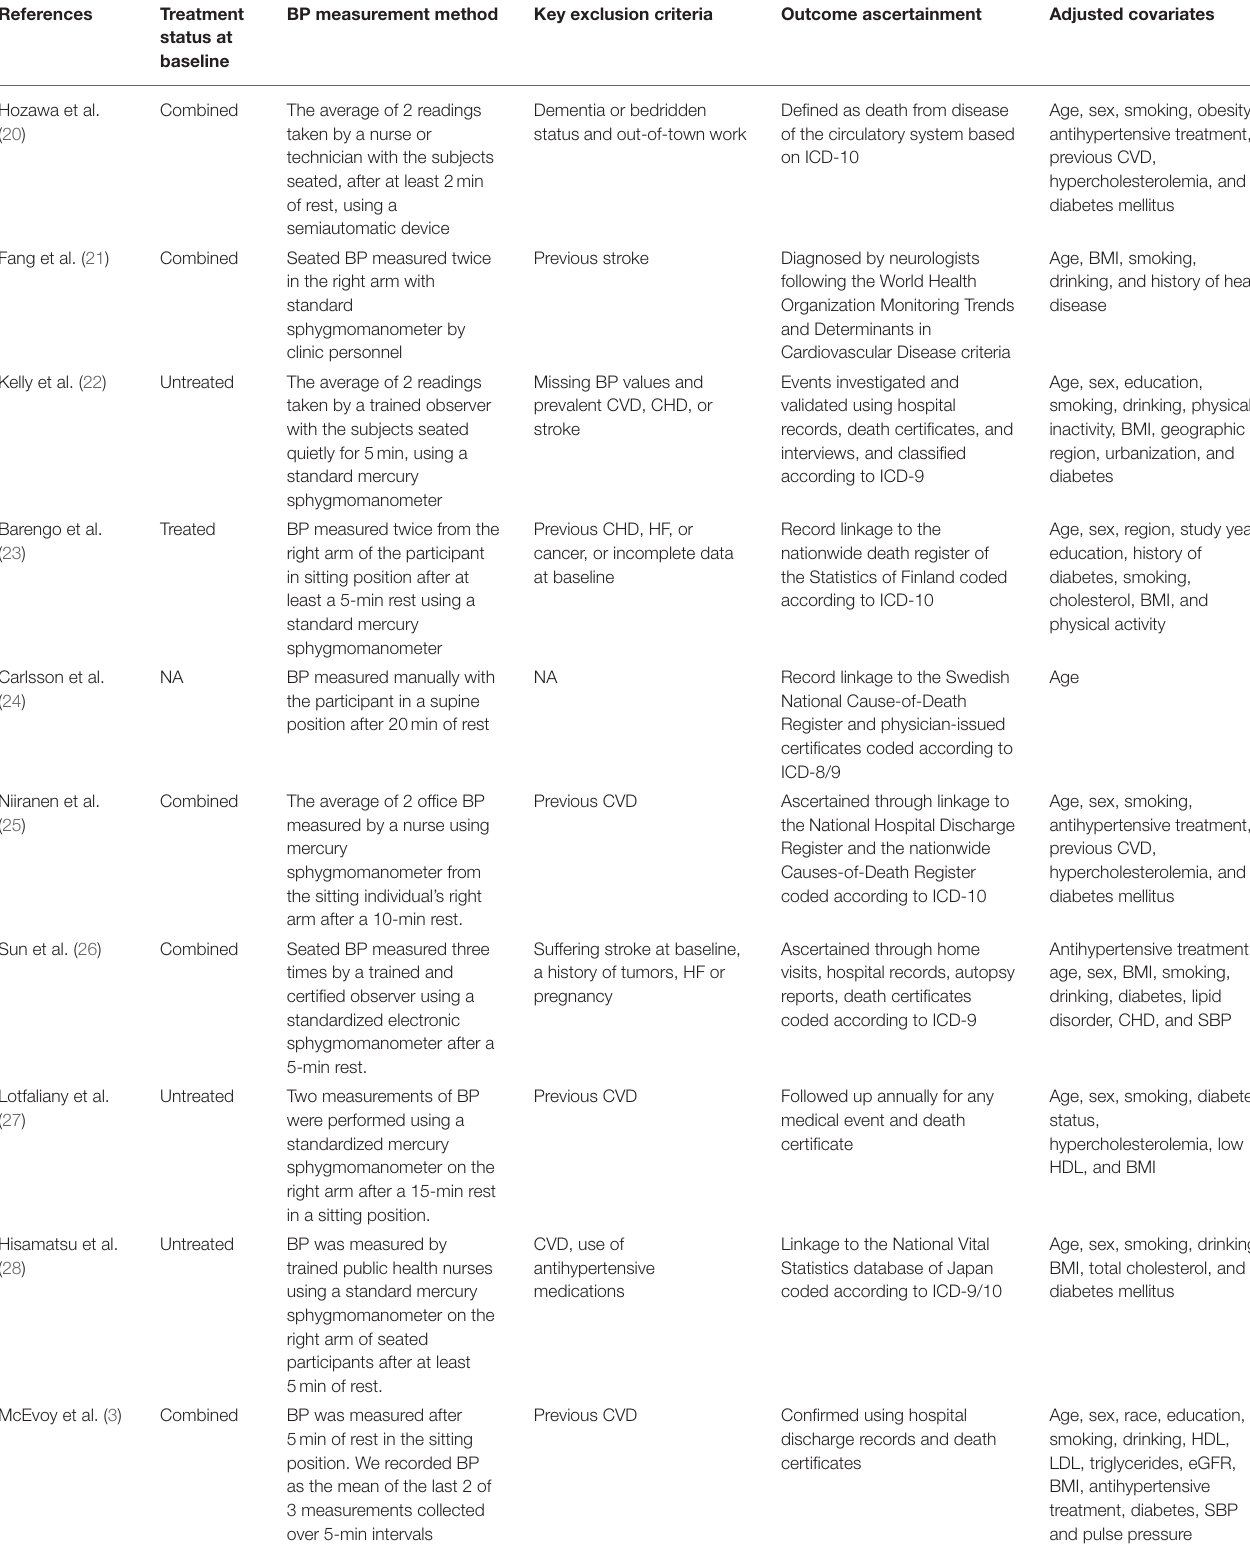
TABLE 2 | Characteristics of included participants and outcome